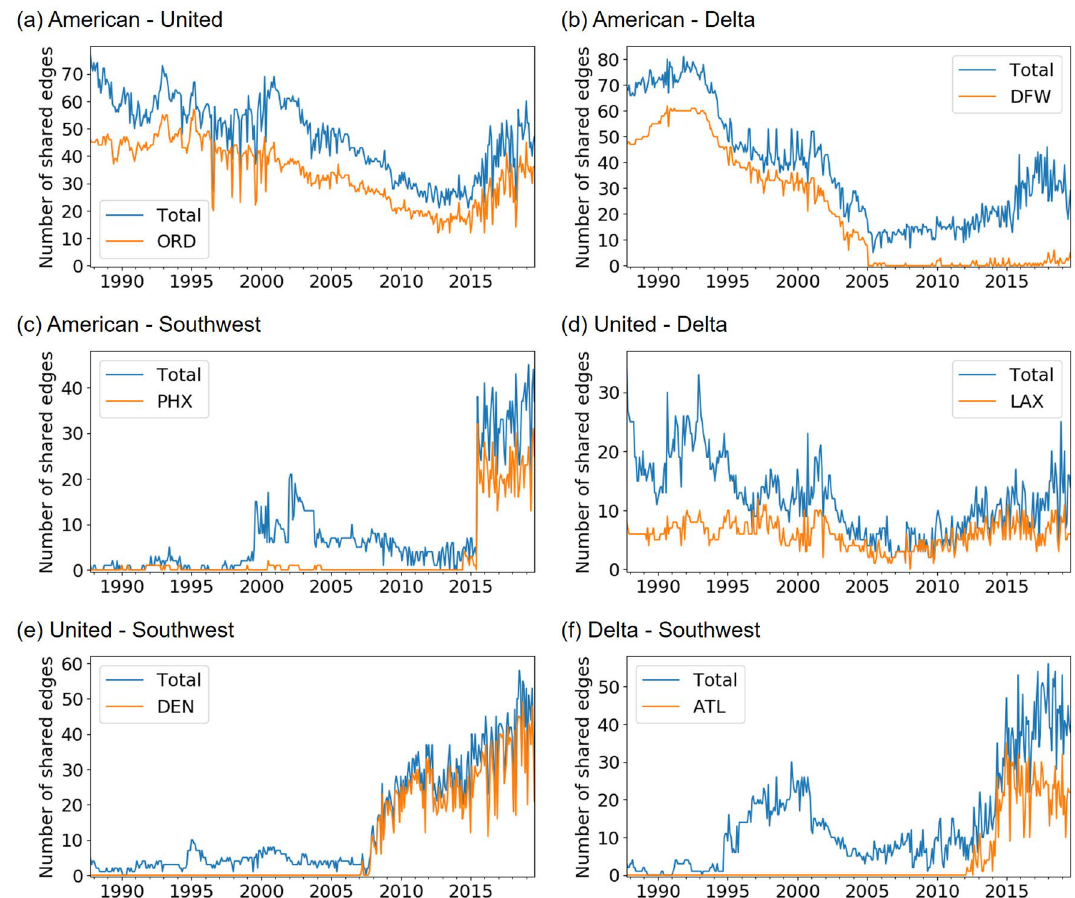
Figure 12. Evolution of the number of edges shared by pairs of carriers. We show the total number of shared edges and the number of shared edges connecting to major airports for each pair of carriers. ( a ) American Airlines versus United Airlines, ( b ) American Airlines versus Delta Air Lines, ( c ) American Airlines versus Southwest Airlines, ( d ) United Airlines versus Delta Air Lines, ( e ) United Airlines versus Southwest Airlines, and ( f ) Delta Air Lines versus Southwest Airlines. ORD: O’Hare International Airport, DFW: Dallas/Fort Worth International Airport, PHX: Phoenix Sky Harbor International Airport, LAX: Los Angeles International Airport, DEN: Denver International Airport, ATL: Hartsfield–Jackson Atlanta International